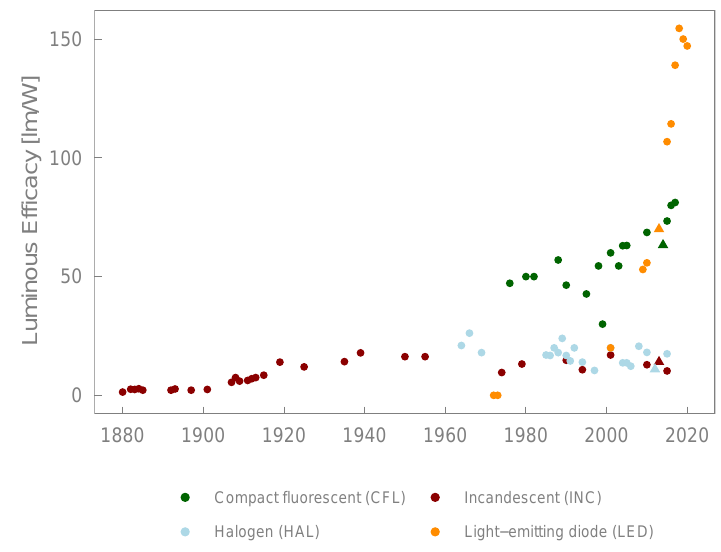
Figure 2. The luminous efficacy of selected lamp technologies from 1880 to 2020. Triangles indicate lamps used as examples in this